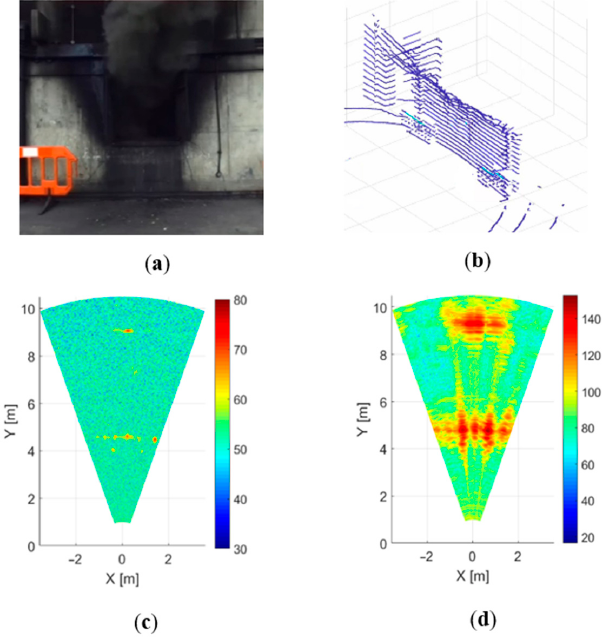
Figure 5. Dense smoke environment:( a ) camera, ( b ) LIDAR, ( c ) 300 GHz radar and ( d ) 79 GHz radar.